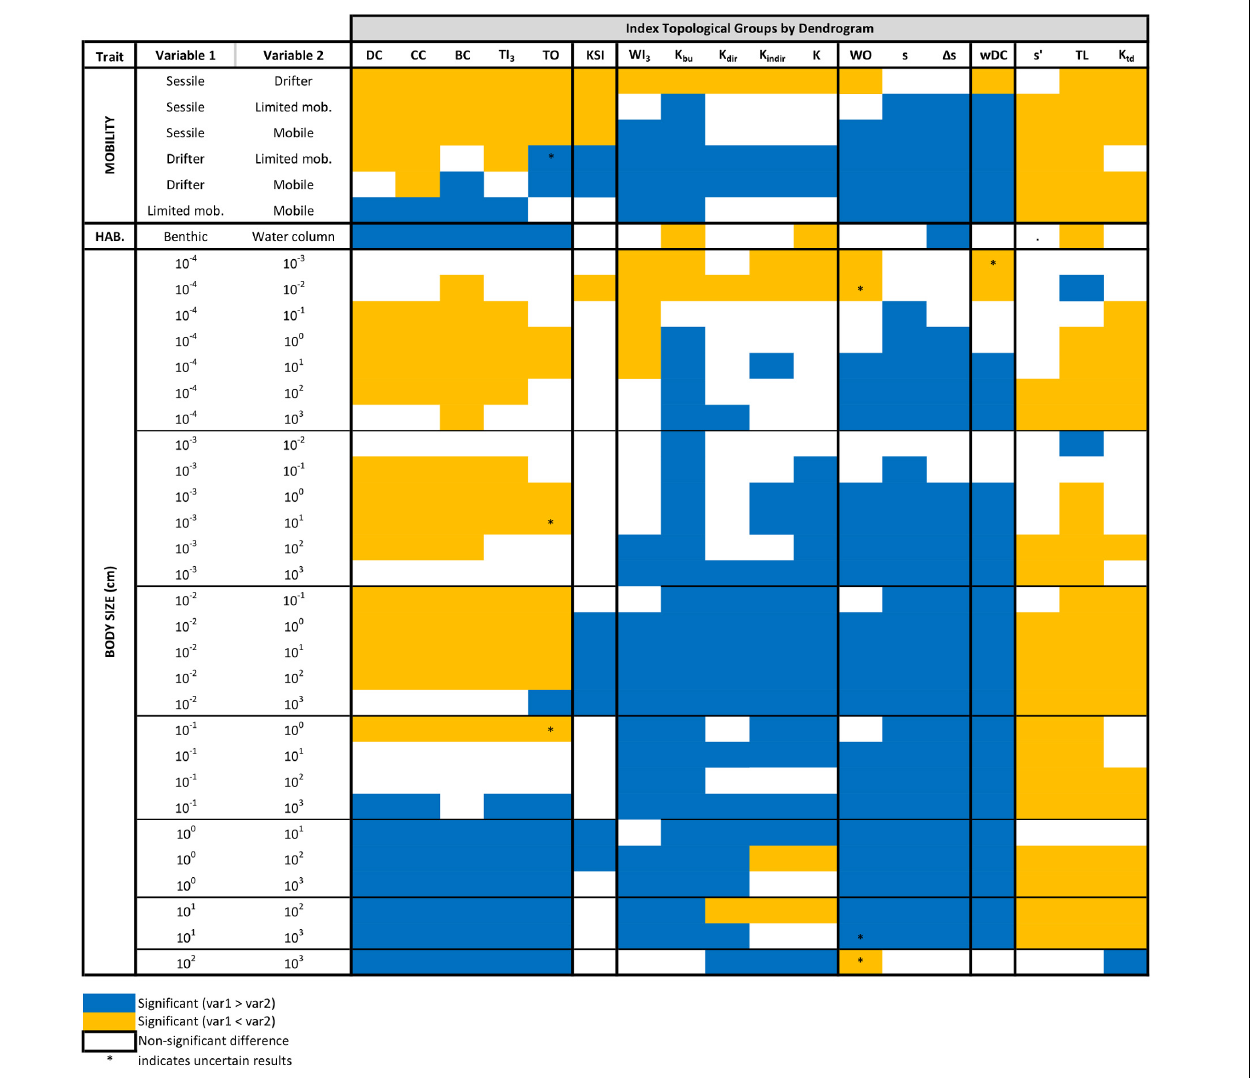
FIGURE 5 | The relevance of each topological index for separating each possible pair of trait values. Significant differences between the topological positions of nodes with different trait categories are marked by colors. For example, the first row shows that DC is different for sessile and drifter organisms but does not separate